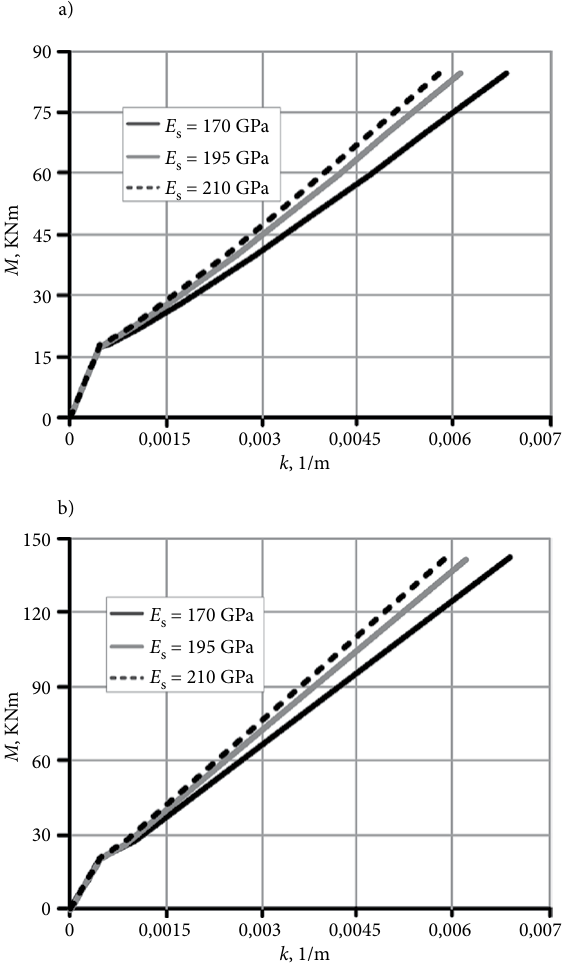
4 pav. Momentų ir kreivių diagramos kintant armatūros tamprumo moduliui: a - r = 1,0 %; b - r = 2,0 % Fig. 4. Moment-curvature diagrams of ranging an elastic modulus of reiforcement: a - r = 1,0 %; b - r = 2,0